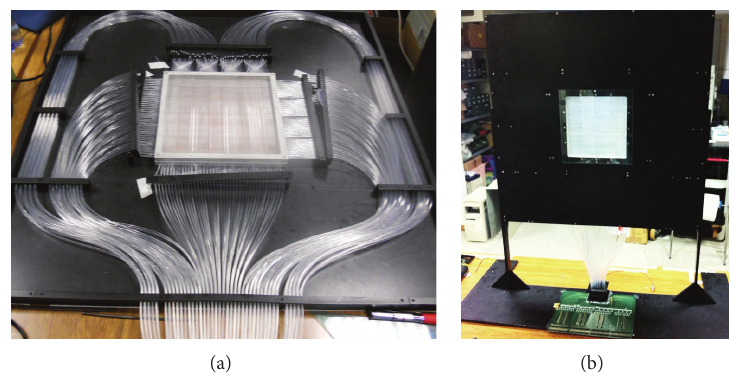
Figure 4: (a) The OFFSET tracker without the cover and (b) the complete OFFSET